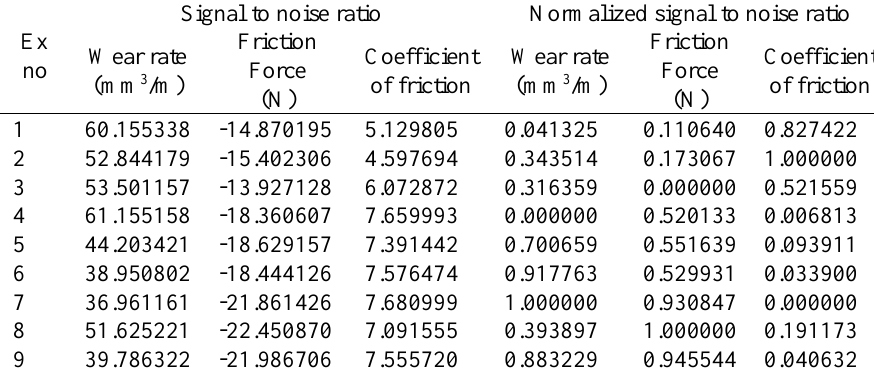
Table 4. Signal to noise ratio and normalized signal to noise ratio values.